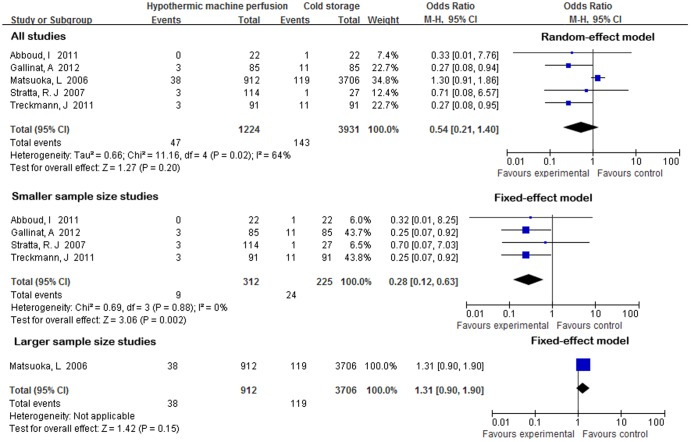
PNF rates for ECD kidneys preserved by HMP versus CS.